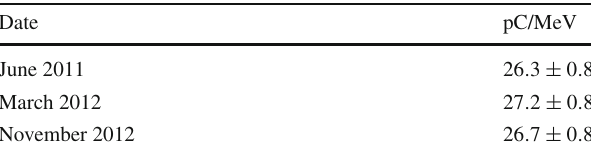
Fig. 2 Typical spectrum from 60 Co calibration: black and red dots represent experimental data and Monte Carlo simulation respectively. The energy scale has been established with 3% accuracy. In addition to the full absorption peak, corresponding to events completely contained in the activevolume of the detector, we candistinguish a bump of events corresponding to one of the two gammas escaping the detector Table 1 Summary of calibration factors measured during the data tak- ing